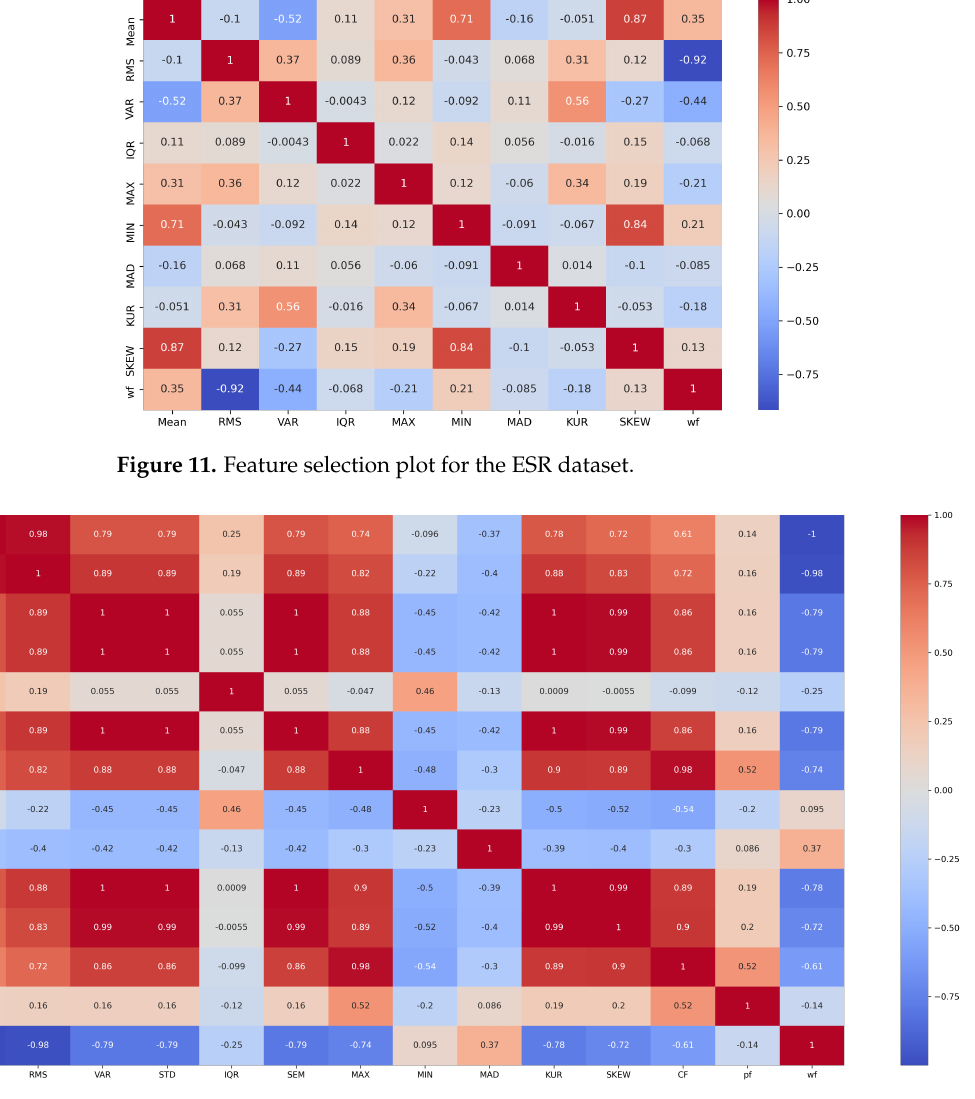
Figure 12. Feature extraction plot for the Impedance dataset.